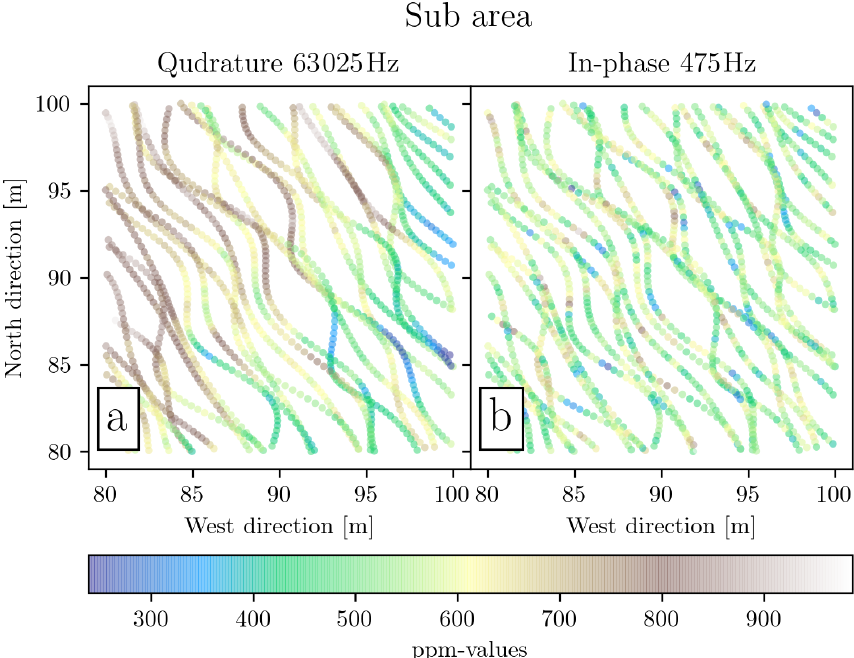
Figure 9. Close-up picture of a part of the Falster survey data (see black box in Fig. 8). Note the inconsistency in values between adjacent survey